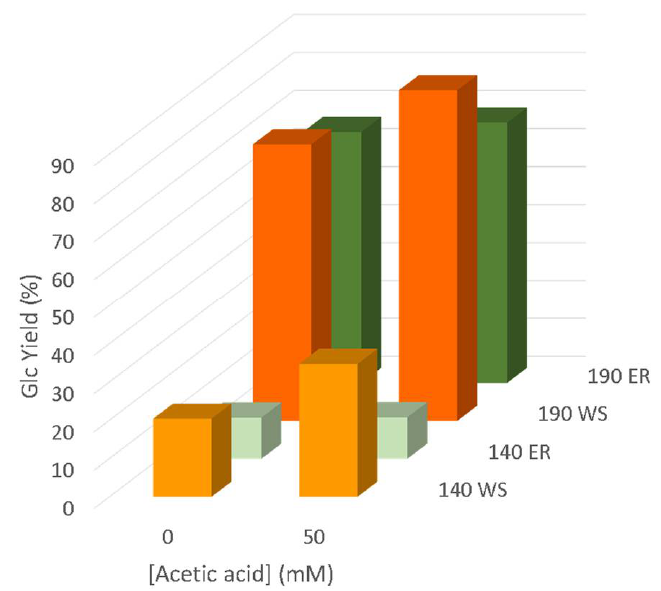
Figure 8. Comparison of enzymatic saccharification of ethanol–water organosolv pulp obtained at 140 °C and 190 °C without (0) or with 50 mM acetic acid (50) as catalyst for wheat straw (WS) and eucalyptus residues (ERs).